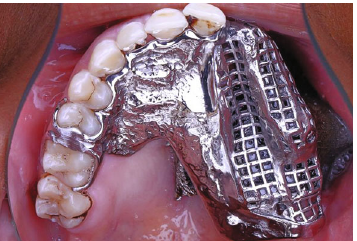
Figure 3: Intraoral occlusal view showing metal framework